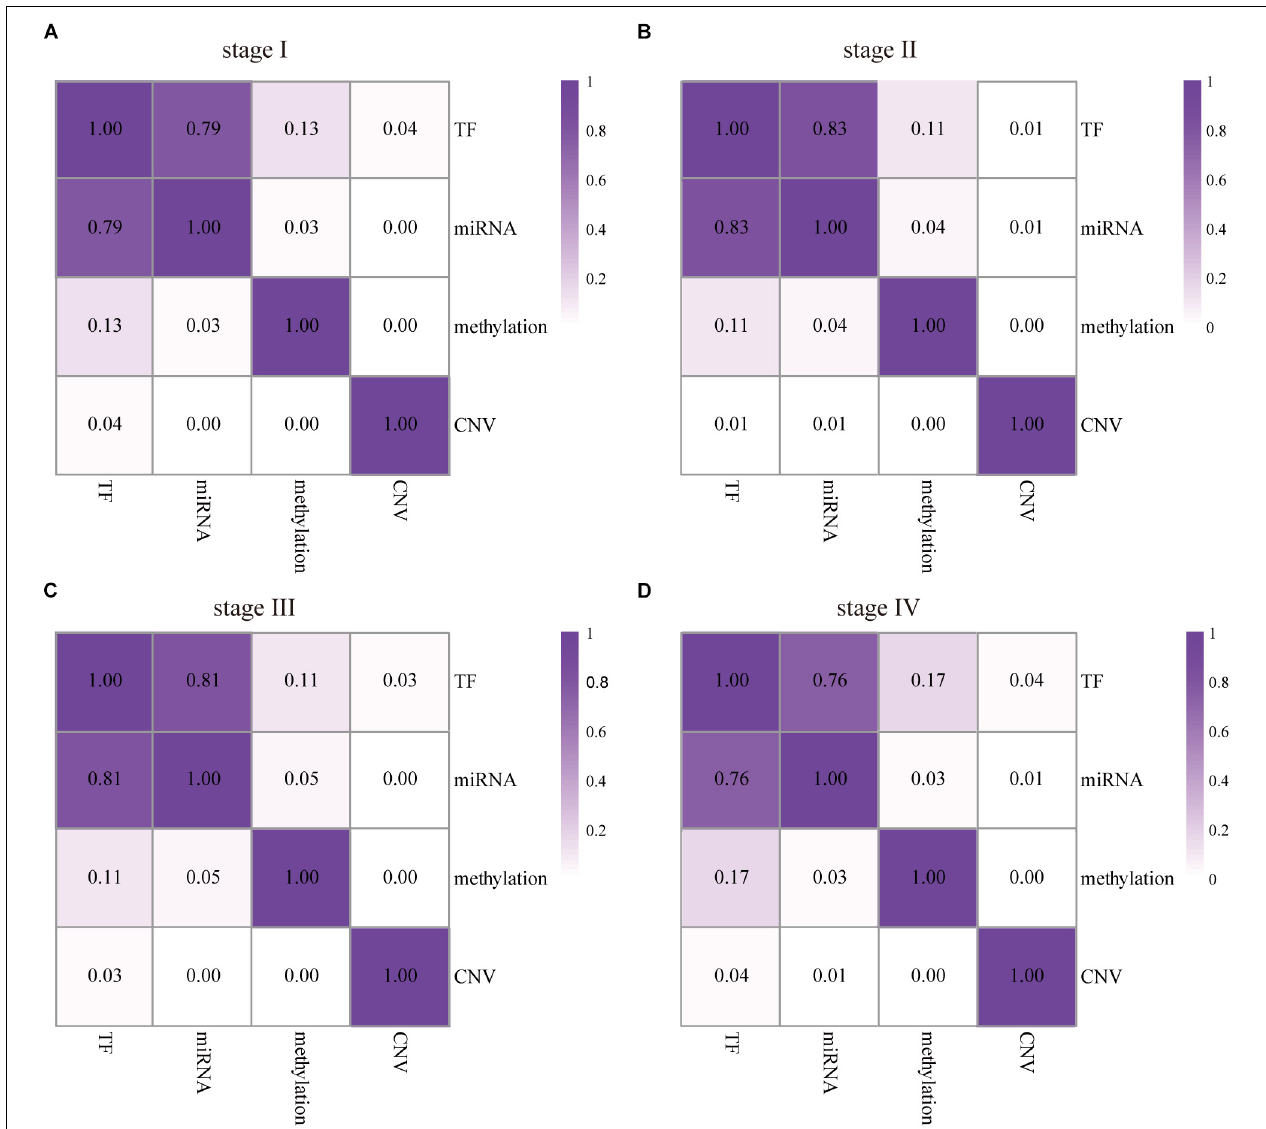
FIGURE 4 | The influence of any two factors to DEAGs in the four stages of COAD. The numbers represent the proportion of the DEAGs regulated by each pair of upstream regulators in stage I (A) , II (B) , III (C) , and IV (D) . The darker color represents a larger